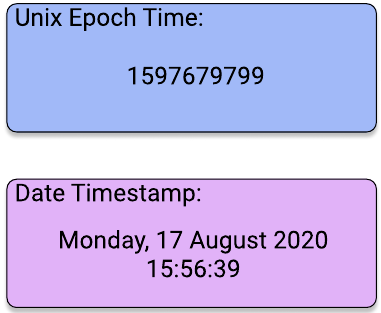
Figure 5. Unix Epoch Time format and corresponding time and